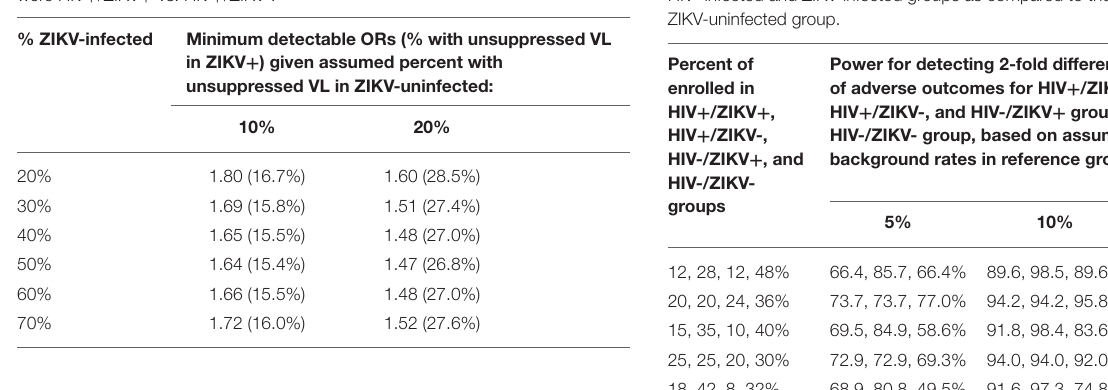
TABLE 1 | Minimum detectable odds ratios (ORs) (and percent with unsuppressed VL among ZIKV- infected) at 80% power comparing women who were HIV + /ZIKV + vs. HIV + /ZIKV-.